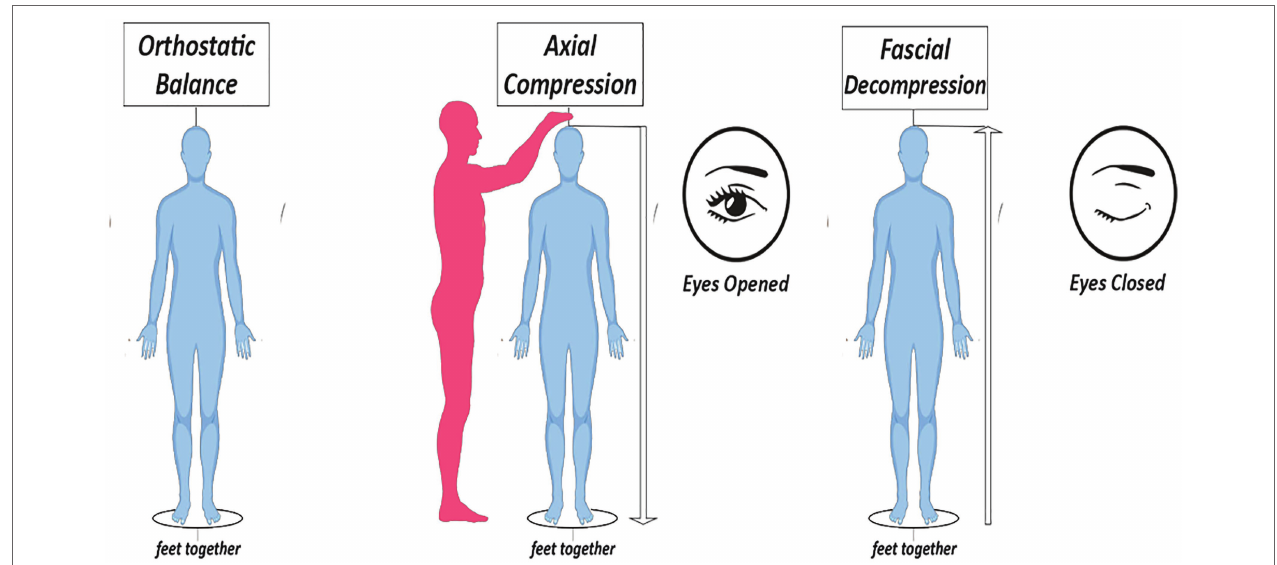
FIGURE 1 | Description of the Pressure and Oscillation Test